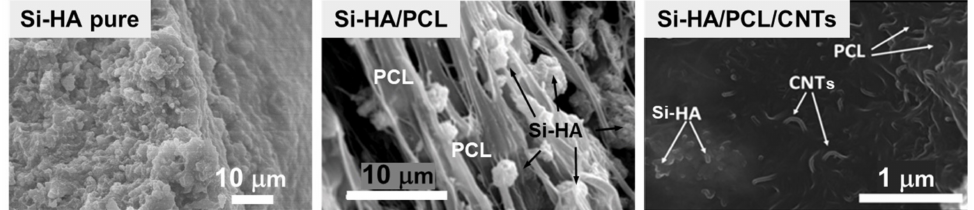
Figure 7. SEM micrographs at high magnifications inside filaments of Si-HA pure scaffold obtained through thermal treatment by removed MMA + MBAA ( left ), and two different Si-HA composites: Si-HA/PCL where Si-HA was embedded in PLC fibers (( middle ), reproduced with permission from Meseguer-Olmo et al. [120], J. Biomed. Mater. Res. Part A; published by Wiley, 2013) and Si-HA/PCL/CNTs where CNTs and Si-HA were homogeneously dispersed in organic phase (( right ), reproduced with permission from Gonçalves [121], J. Biomed. Mater. Res. Part B Appl. Biomater.; published by Wiley,